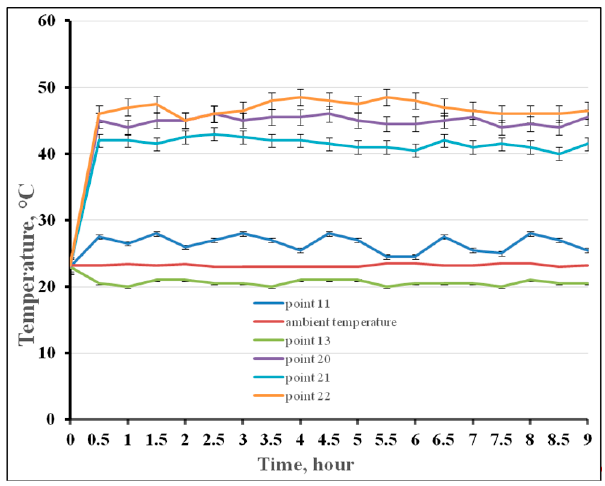
Figure 9. Dependence between the temperature in control points 11–22, and the work time of the installation.